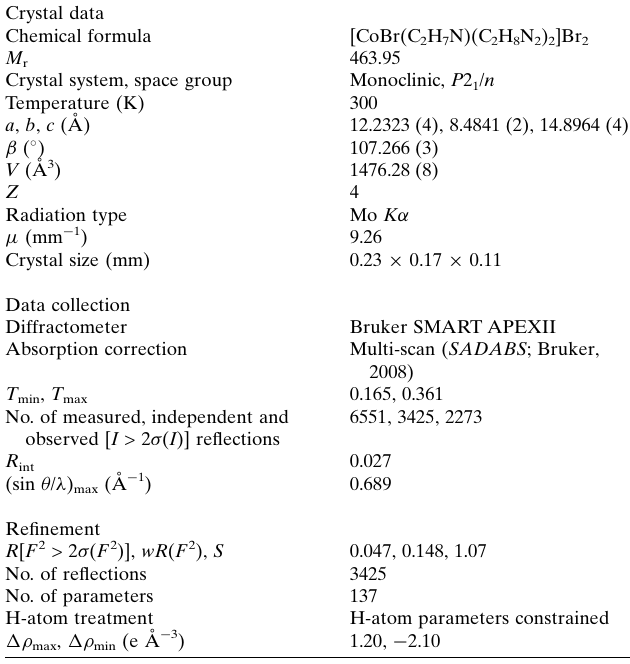
Crystal data Chemical